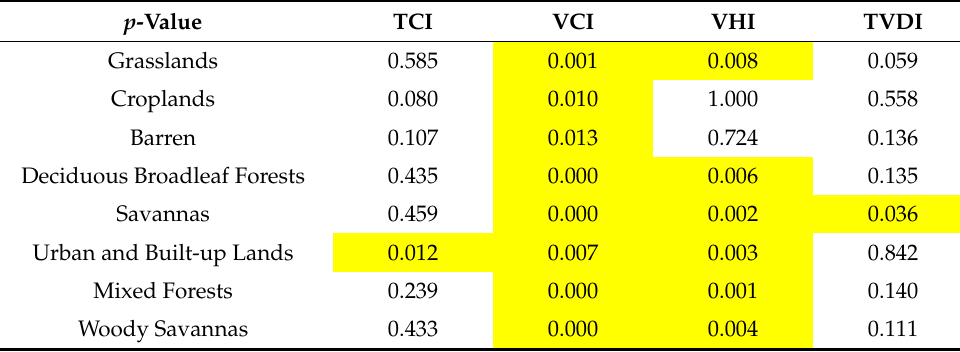
Table 9. Statistic of p -Value in different land cover types.